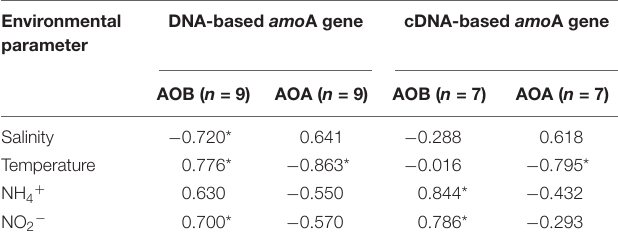
TABLE 1 | The Pearson correlations between environmental parameters and total abundances of DNA-based and cDNA-based amo A genes of AOB and AOA on the three size-fractionated